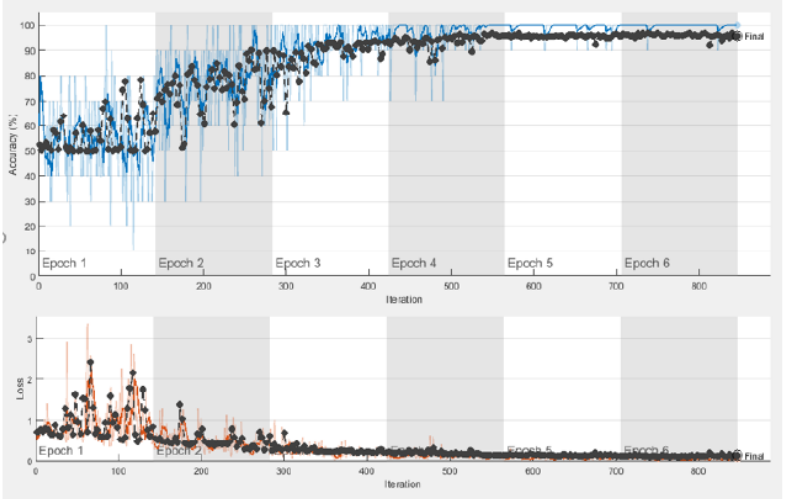
Figure 9. Training progress curve for InceptionResNetv2-MCSVM-based model with image SR using dataset #1. Table 5. Results for pre-trained models with image SR using dataset #1.